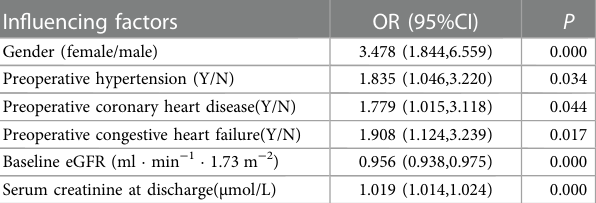
TABLE 3 In fl uencing factors of progression to CKD in patients 90 days after CS-AKI (multivariate logistic regression analysis).